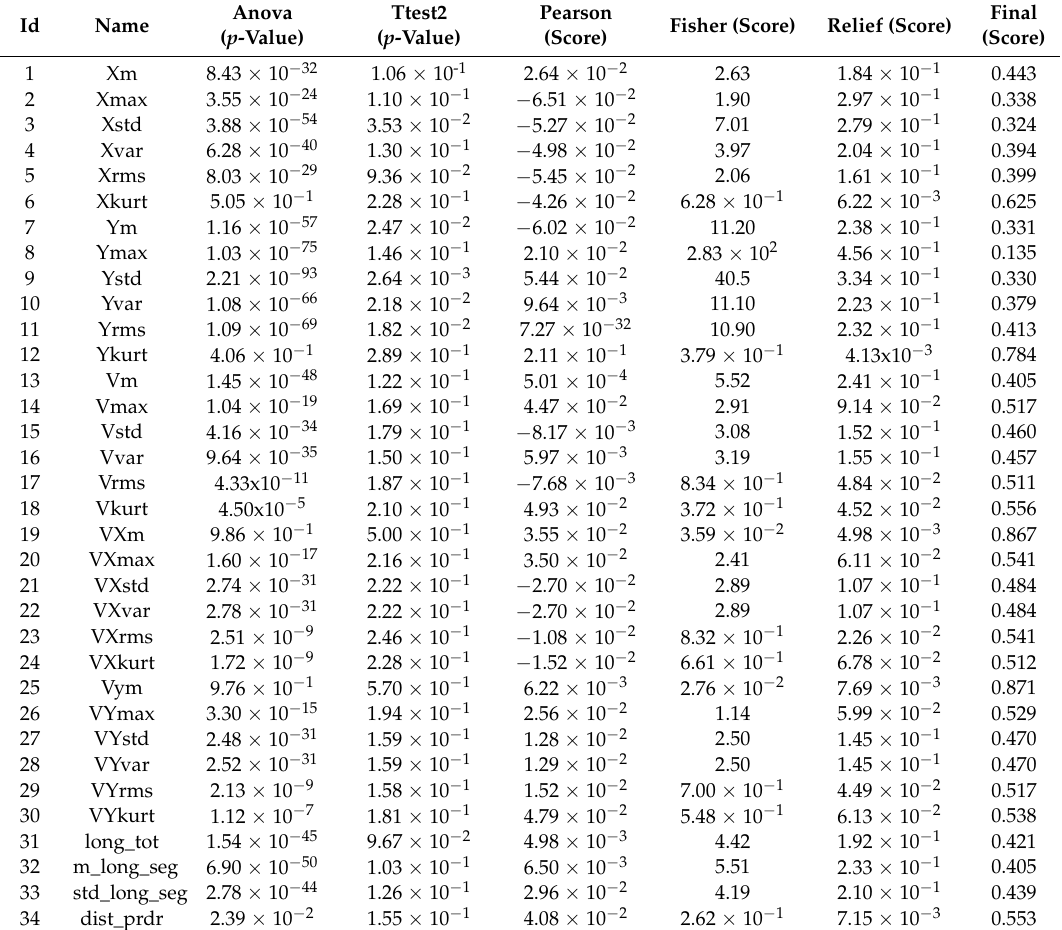
Table A1. Scores obtained by the filter feature selection